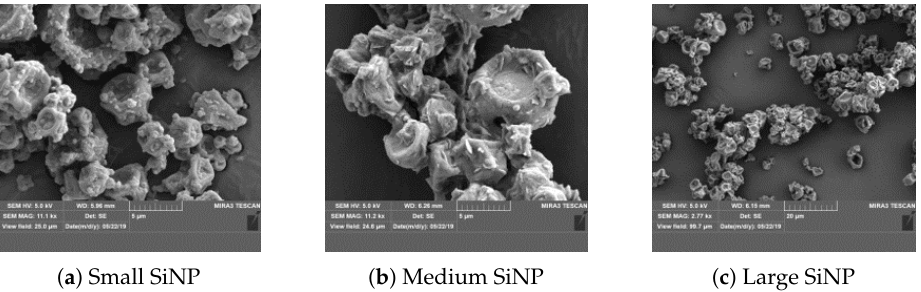
Figure A7. Effect excipient size on particle morphology. All were formulations spray dried from buffer at pH 5.5 containing no CaCl 2 .